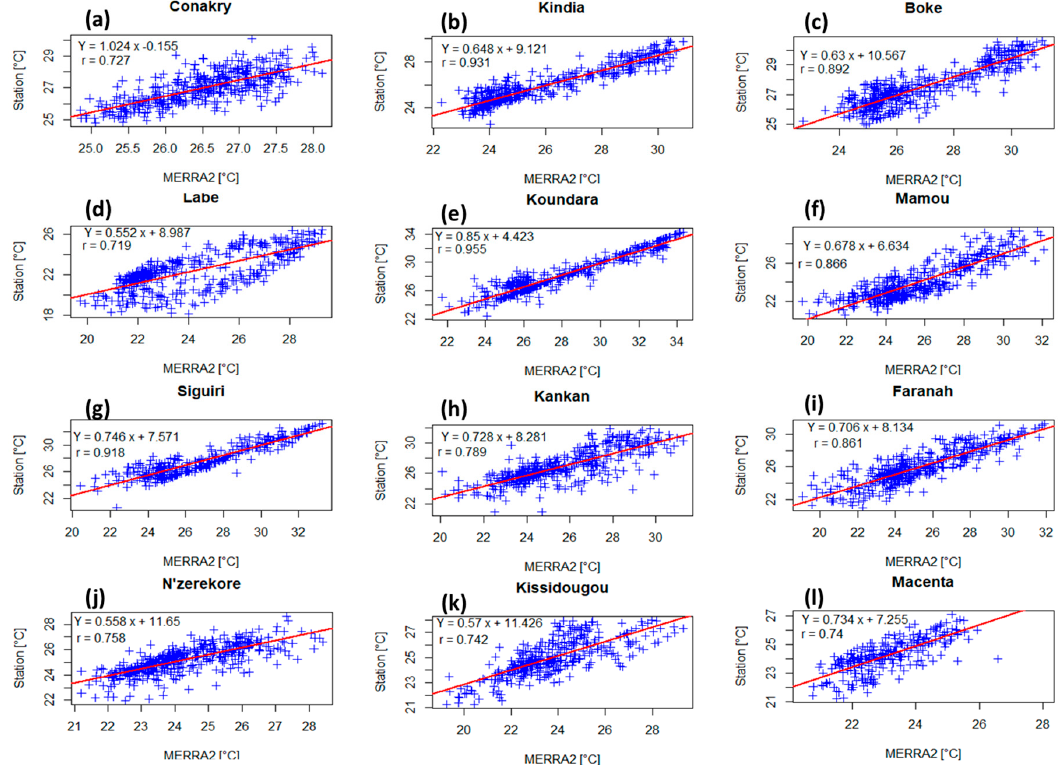
Figure 2. Pearson correlation between ground-based data and Modern Era Retrospective-Analysis for Research and Applications (MERRA 2) temperature data for the 12 sites ( a – l ) for the period from 1980 to 2016.